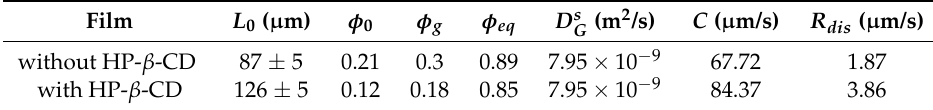
Figure 6. Swelling-erosion tests. ( A ) Experimental data W ( t ) / W 0 vs. t (min). ( B ) Experimental data and model predictions W ( τ ) / W 0 vs. the dimensionless time τ . The maximum swelling degree is W max / W 0 (cid:39) 3.5 with and without HP- β -CD. Table 1. Parameters entering the swelling-erosion